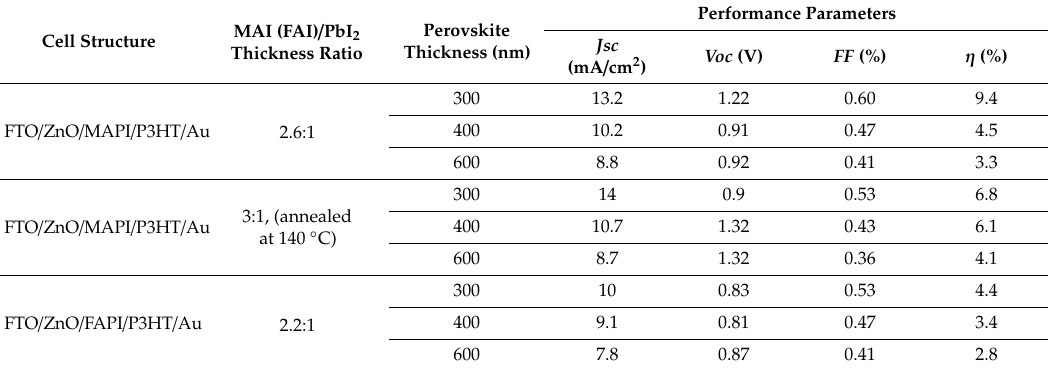
Table 3. Influence of the thickness and composition of the active layer of perovskita on the performance parameters ( Jsc , V OC , FF and η ) of solar cells fabricated with structure FTO / ZnO / Perovskita / P3HT / Au. Performance Parameters Perovskite MAI (FAI) / PbI 2 Cell Structure Jsc Thickness (nm) Thickness Ratio (mA / cm 2